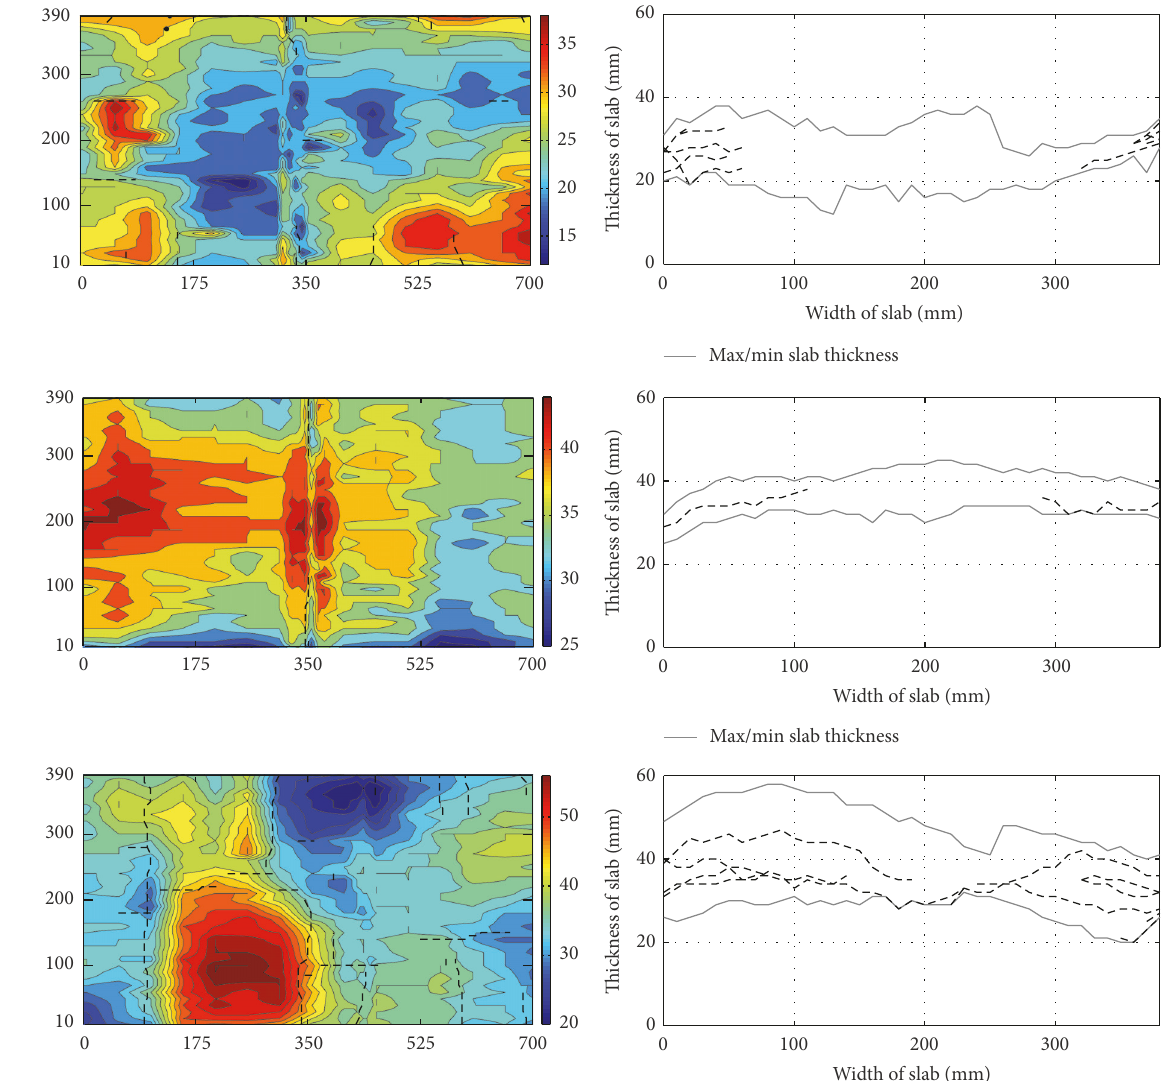
Figure 7: Topographical and sectional plots with crack patterns from numerical analysis of fully bond-restrained slabs S1, S4, and S5 (top to bottom). All measurements in